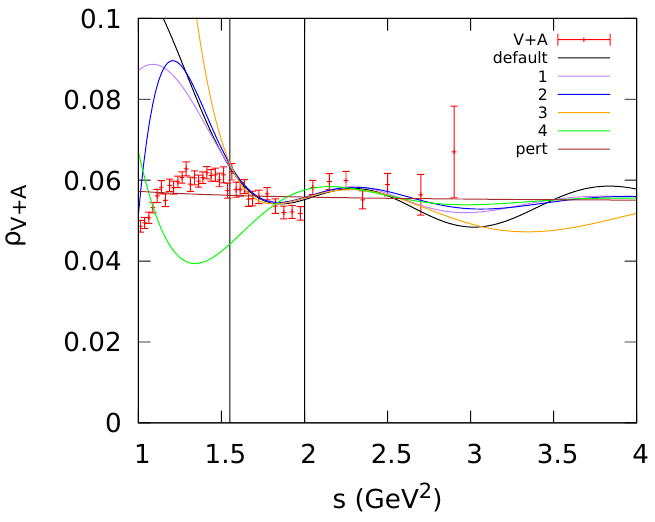
Figure 6 . Hypothetical V + A spectral functions obtained with the different model variations, compared with the experimental